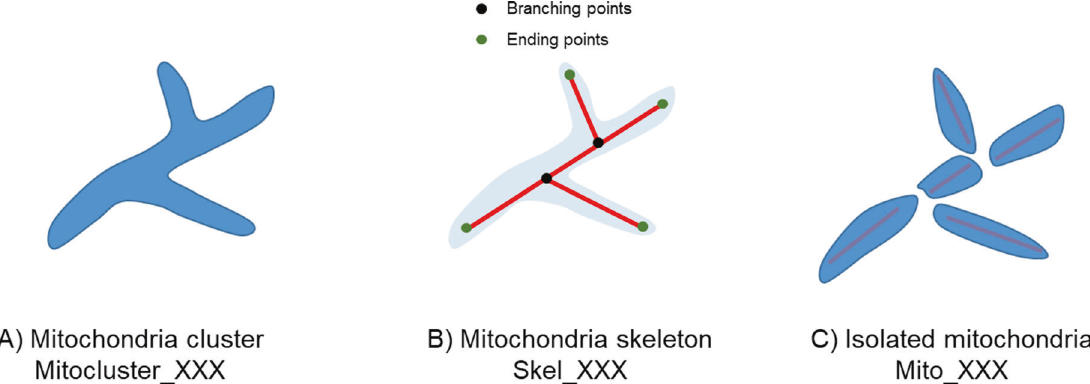
Fig. 1 Process for obtaining mitochondrial morphology parameters. MITOTOUCH ® proprietary software identi fi es mitochondrial clusters, skeletonizes the clusters and divides them into individual mitochondria to derive both cluster and isolated mitochondrial metrics at the single cell